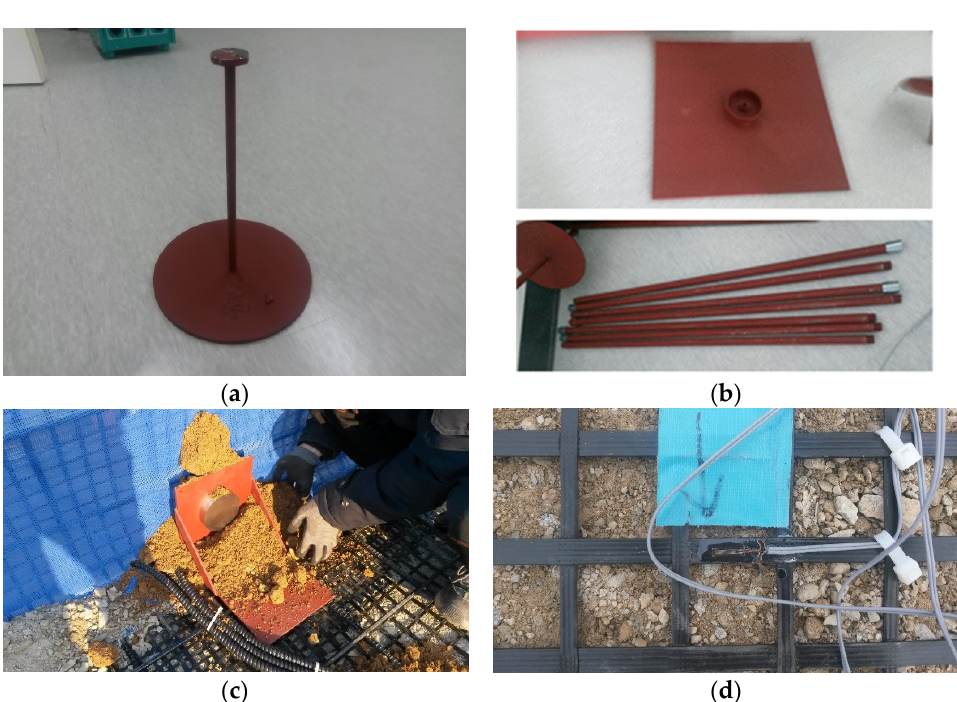
Figure 5. Location of installed sensors.